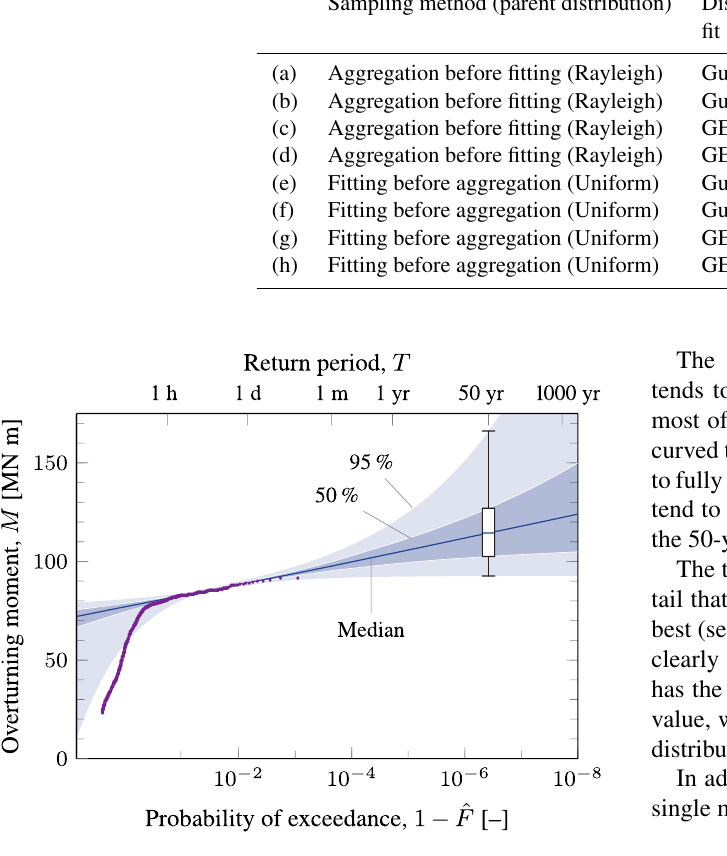
Figure 7. Return level plot of the tower base overturning moment, showing all the k = 10 3 GEV fits with a sample size of N = 10 3 . The dot markers belong to one of the 10 3